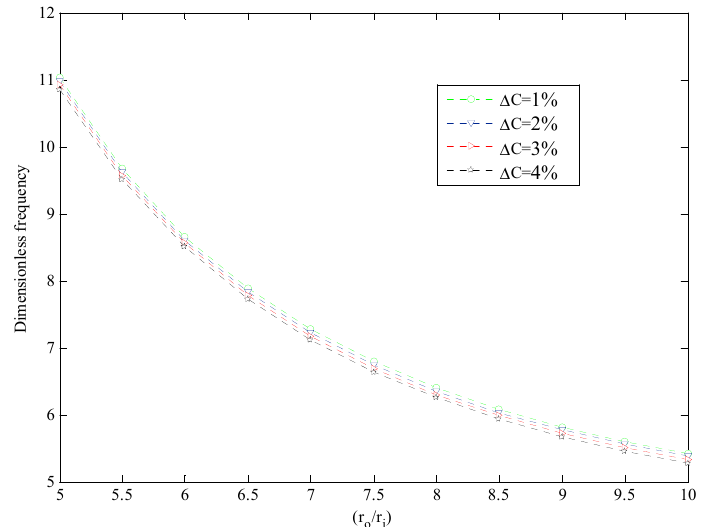
Figure 7. Dimensionless frequency versus radial ratio for different variations in moisture.